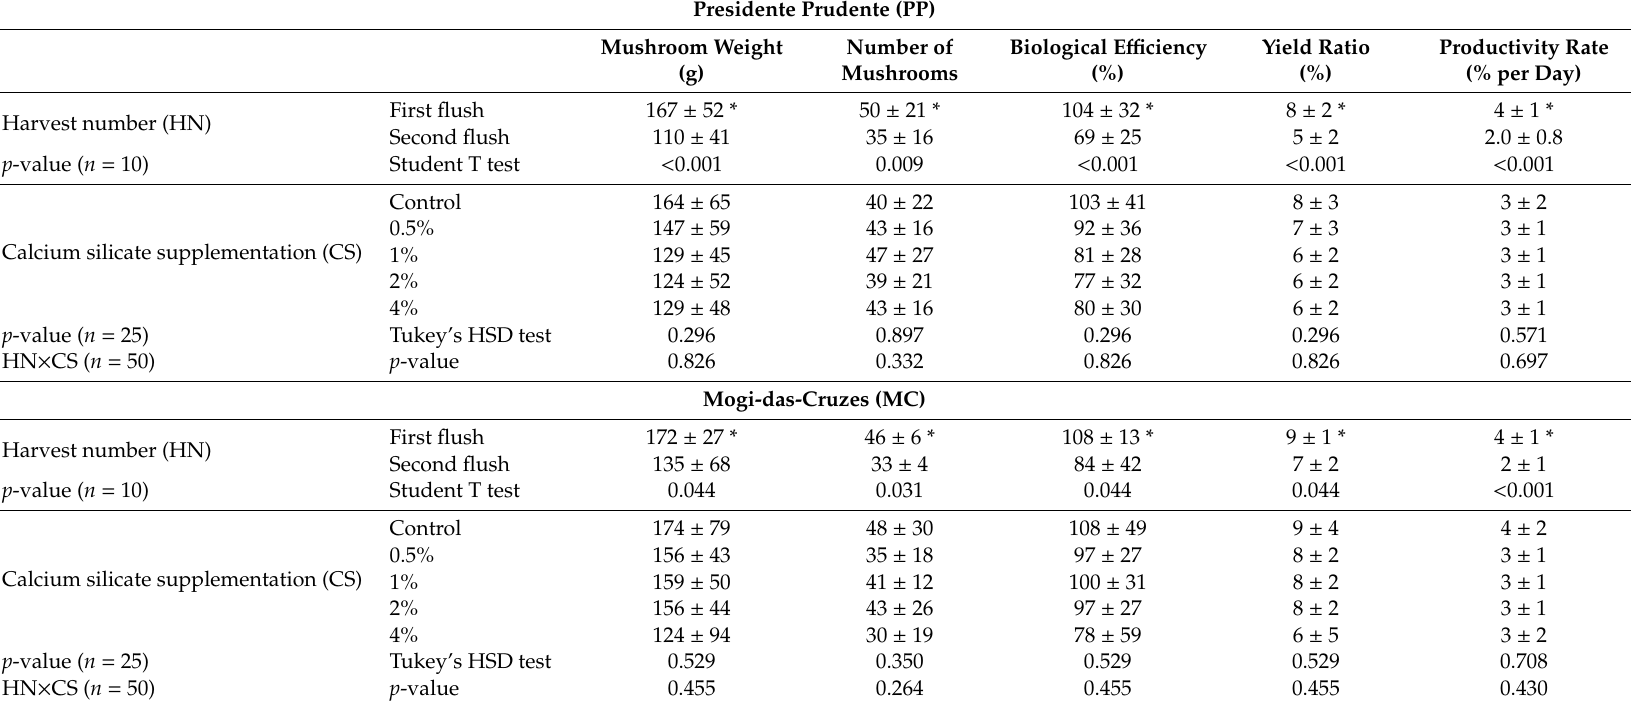
Table 1. Biological parameters of the two strains during the two harvest periods and di ff erent supplementation